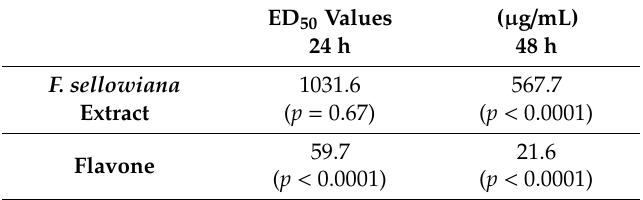
Table 1. E ff ective dose 50 (ED 50 ) values of the Feijoa sellowiana extract and flavone in SNU-1